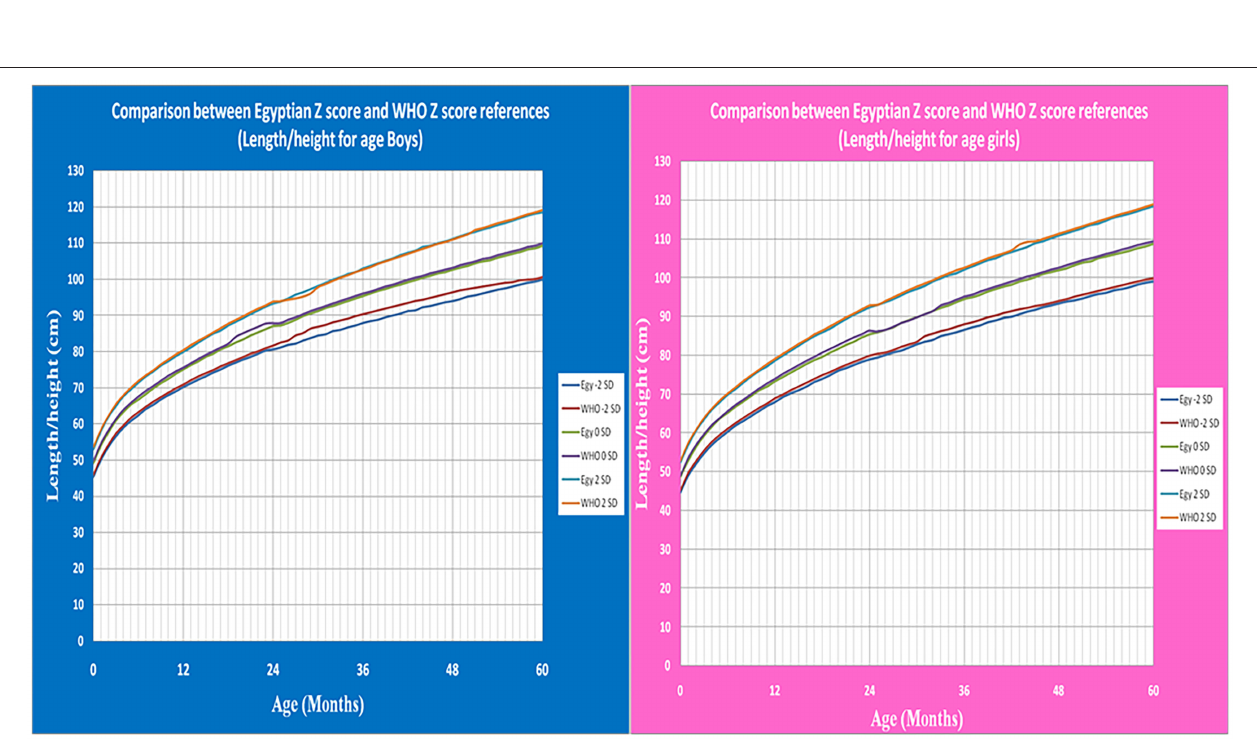
FIGURE 9 | The comparison between Egyptian Z score and WHO Z score references value from birth up to 5 years (Length/height for age in boys & girls).